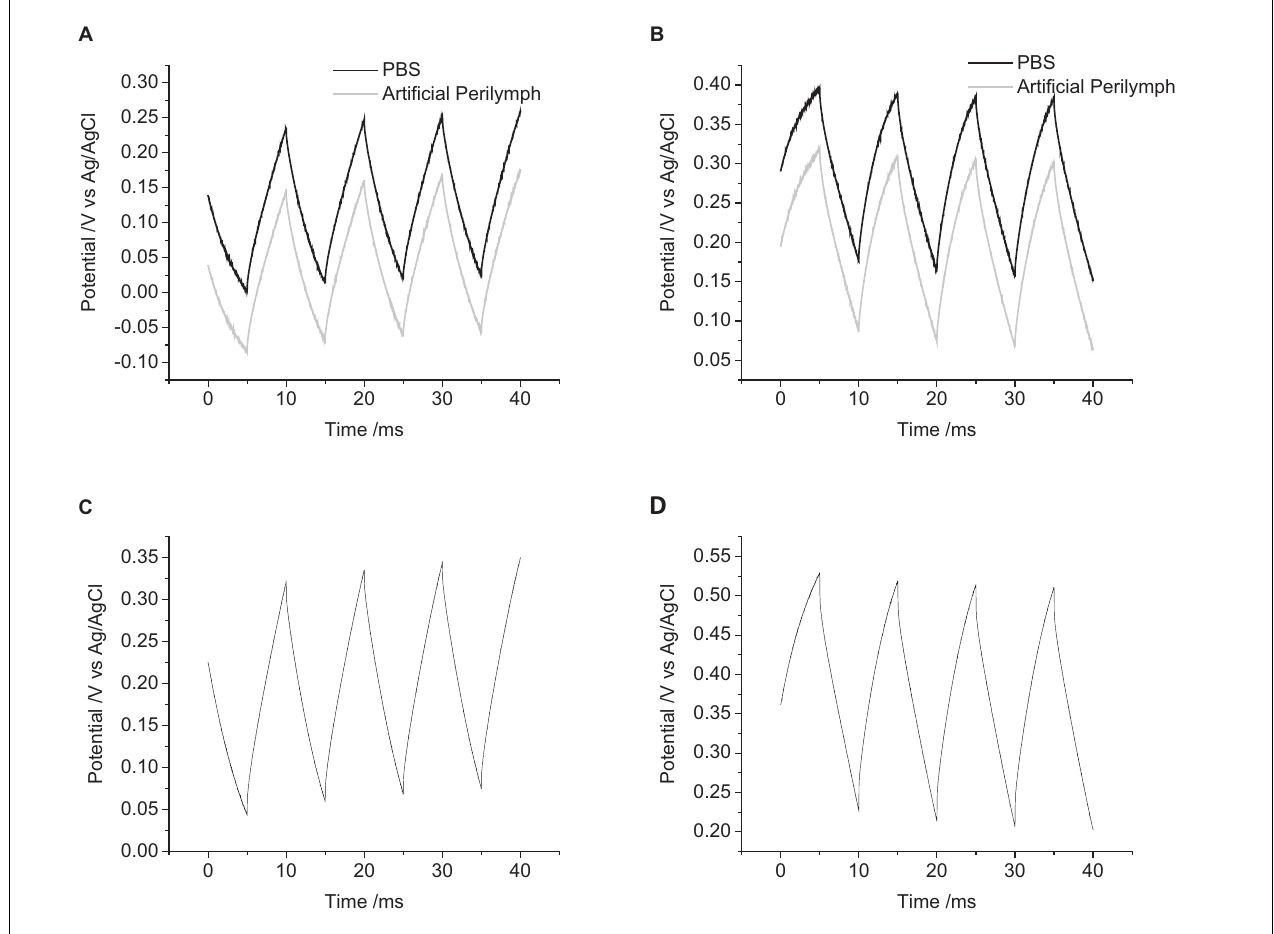
FIGURE 5 | Multiple pulse chronopotentiometry of a mechanically polished 0.6 mm diameter platinum electrode. (A) Cathodic, (B) anodic pulse first with a current density of 10 µ C cm − 2 in degassed solution. Black curve – PBS, Gray curve – artificial perilymph. (C) Cathodic, (D) anodic pulse first with a current density of 10 µ C cm − 2 in non-degassed 0.1 M